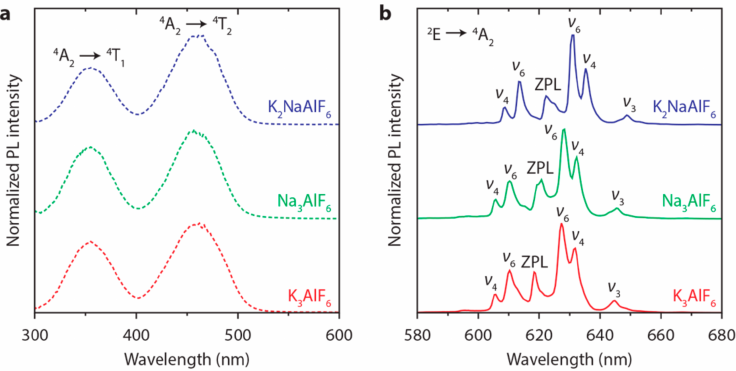
Figure 3. Room-temperature luminescence spectra of M 3 AlF 6 :Mn 4+ (M = Na, K) phosphors. ( a ) Excitation spectra of K 3 AlF 6 :Mn 4+ (1.2%) (red, λ em = 628 nm), Na 3 AlF 6 :Mn 4+ (0.4%) (green, λ em = 628 nm) and K 2 NaAlF 6 :Mn 4+ (0.9%) (blue, λ em = 631 nm). The broad excitation bands correspond to the Mn 4+ 4 A 2 → 4 T 1 and 4 A 2 → 4 T 2 transitions; ( b ) Emission spectra ( λ exc = 460 nm) of K 3 AlF 6 :Mn 4+ (1.2%) (red), Na 3 AlF 6 :Mn 4+ (0.4%) (green) and K 2 NaAlF 6 :Mn 4+ (0.9%) (blue). The Mn 4+ emission spectra consist of zero-phonon (ZPL) and (anti-)Stokes vibronic ( ν i ) 2 E → 4 A 2 emission